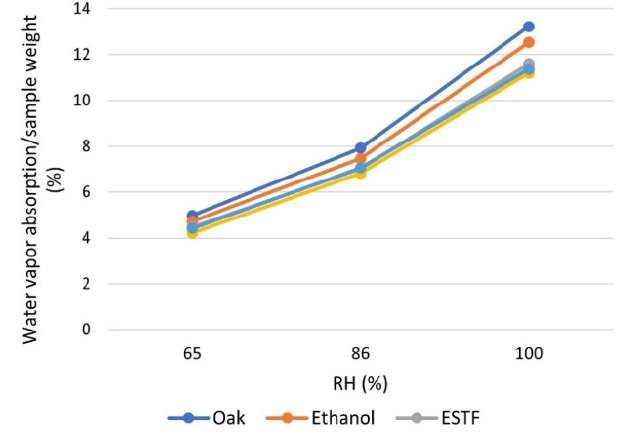
Figure 10. Water vapor absorption per unit of weight (%) over time at different RH values for oak sample, oak sample after ethanol extraction, and oak samples after coating with ESTF, ESF, or DF. The increase in the surface wettability of wood (i.e., lower CA, Table 6) and the Table 7. Total mass of water absorbed at different RH values and mass per unit of weight of the sample (%).